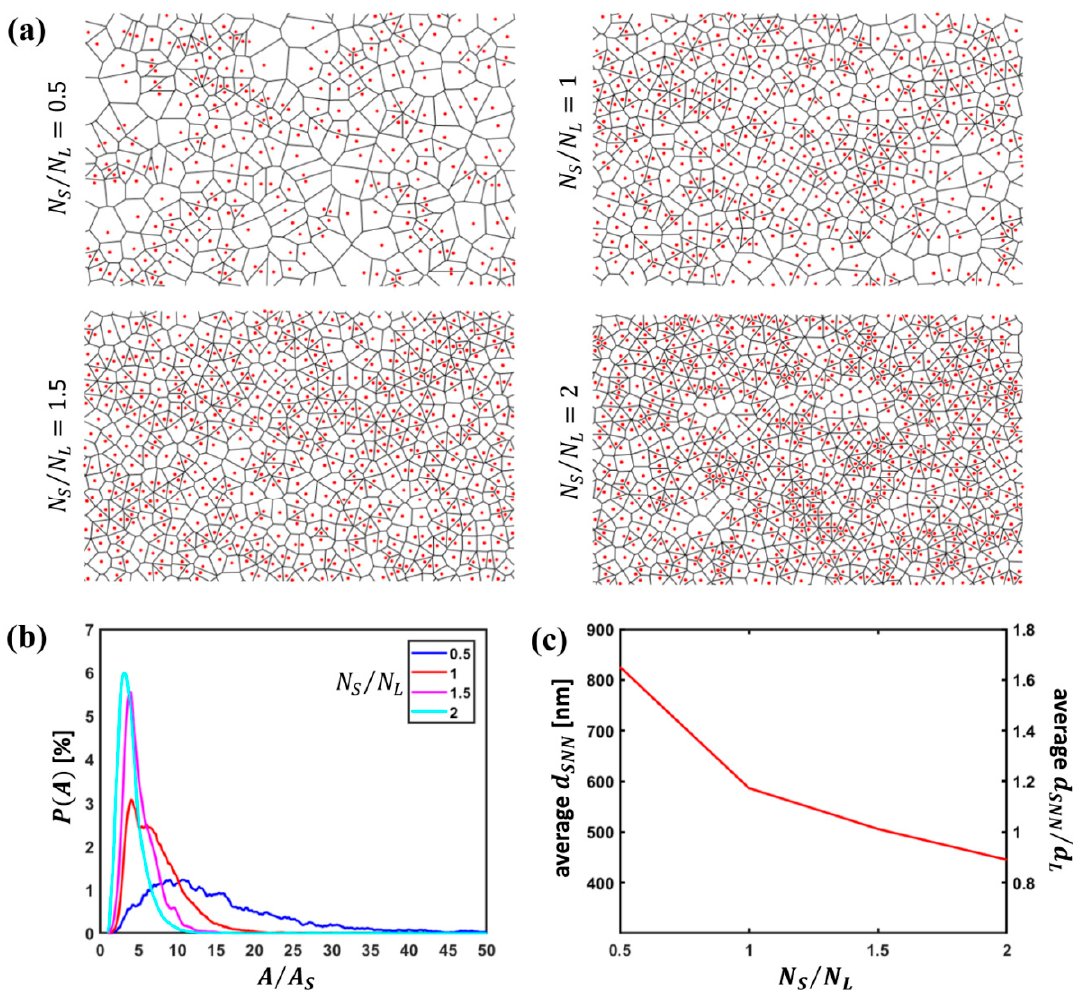
Figure 1. Small particle arrangements and Voronoi diagrams: ( a ) Centroids of S particles and correspondingVoronoitessellationforvariableparticlenumberratioN S /N L ; ( b )probabilitydistribution of the area of the Voronoi cells P ( A ) normalized to the area of a Voronoi cell of an ideal hcp arrangement of S particles; ( c ) average S nearest neighbor inter-particle distance d SNN .